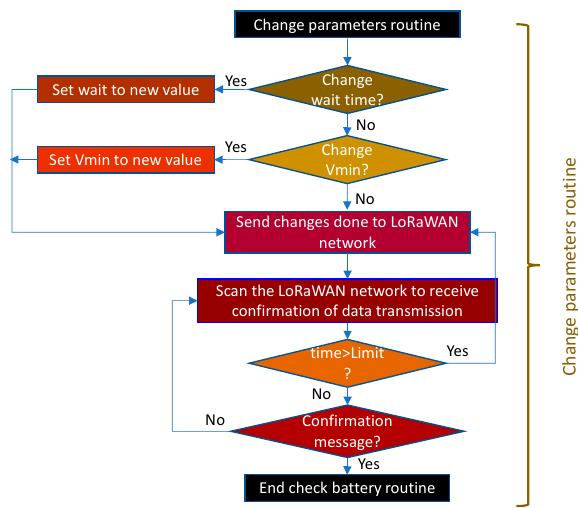
Figure 18. Flow chart of the change parameters routine for the ECDL.